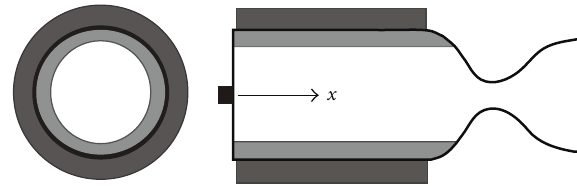
Figure 1: Schematic diagram of sleeved cylindrical-grain SRM, showing reference x